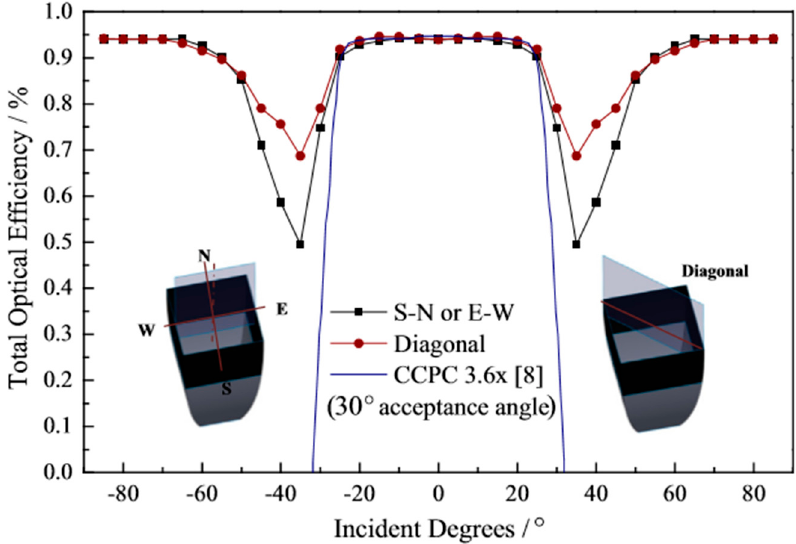
Figure 2. Total optical efficiency of 3.6 × /4 × A/R CCPC under different incident angles. Reproduced from [8], Elsevier, 2016.